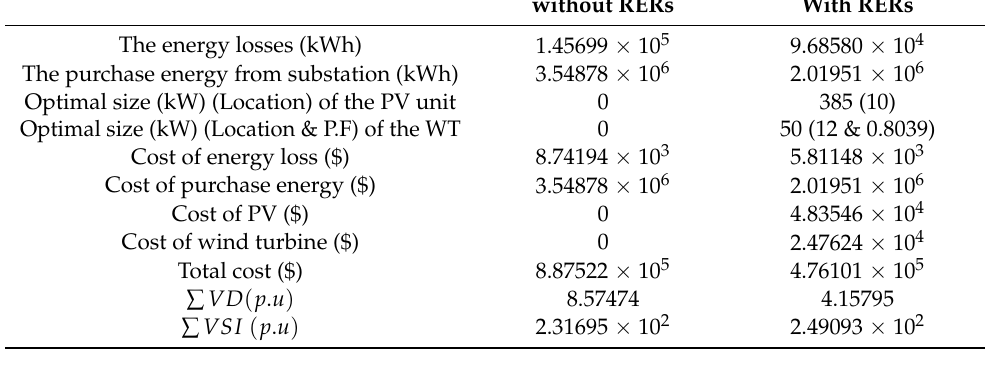
Table 5. The simulation results of energy management of the MG under probabilistic conditions.